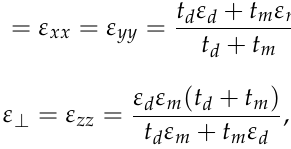
Figure 1. Schematic representation of the considered PHC structure. The gain material is described with ε gain = Re ( ε SiO 2 ) − j α , where ε SiO 2 corresponds to the permittivity of fused silica [37] and α is a parameter corresponding to net gain of the material. In our analysis, the parameters of the gain material correspond to parameters of erbium-doped fused silica thin film [38]. Moreover, the multilayer HMM medium is considered as a homogenous uniaxial anisotropic medium with effective permittivity tensor